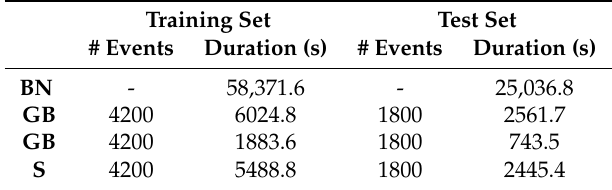
Table 2. Summary of the composition of the dataset created in